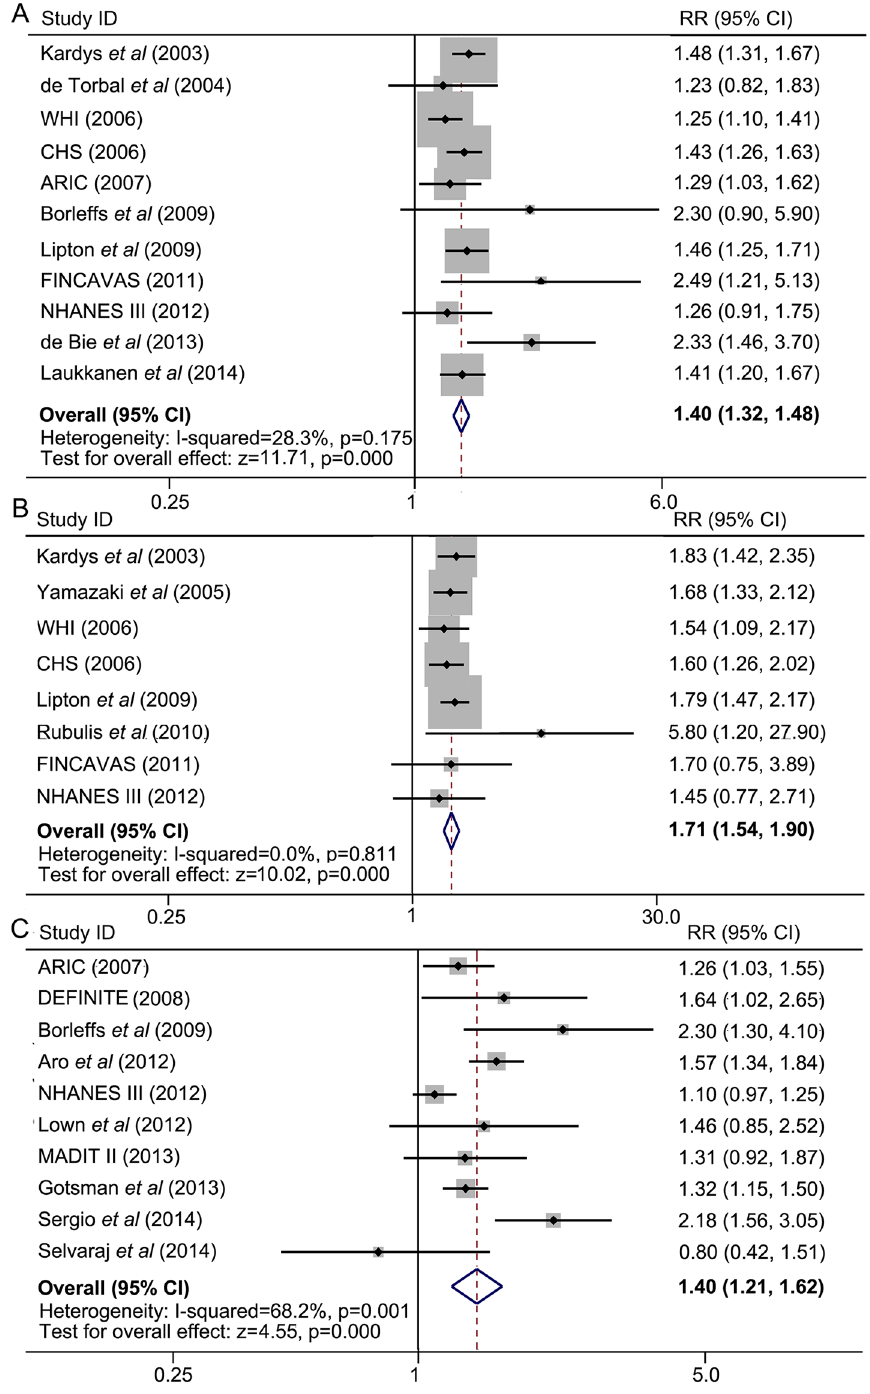
Fig 6. Combined analyses show that a wide spatial QRS-T angle predicts a higher incidence of all- cause death (A) and cardiac death (B), a wide frontal QRS-T angle is associated with a higher rate of all-cause death (C). ARIC: the Atherosclerosis in Communities Study; CHS: the Cardiovascular Health Study; CI: confidence interval; DEFINITE: the Defibrillators in Nonischemic Cardiomyopathy Treatment Evaluation; FINCAVAS: The Finnish Cardiovascular Study; MADIT II: the Multicenter Automatic Defibrillator Implantation Trial II; NHANES III: the Third National Health and Nutrition Examination Survey; RR: relative risk; WHI: The Women ’ s Health